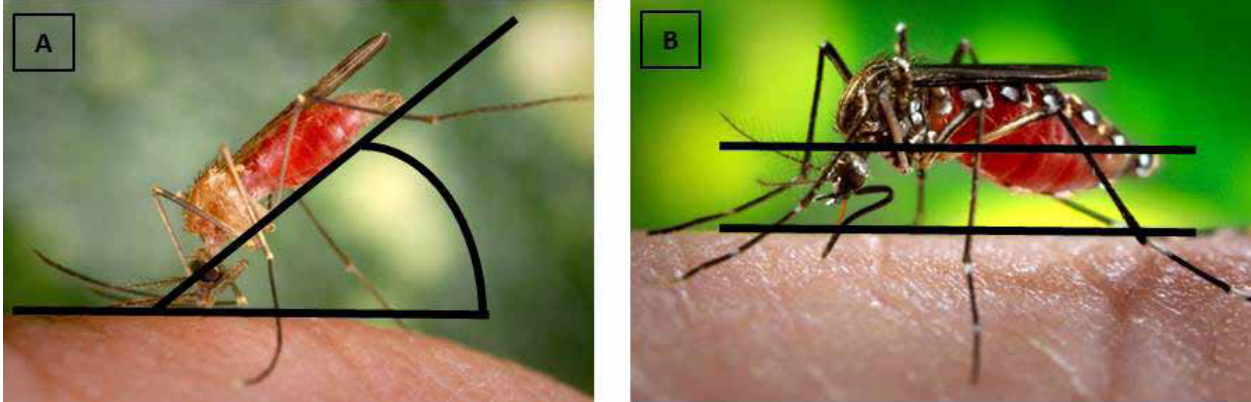
Figure 1: The resting/feeding stance of the female Anopheles species (A), which differentiates them from other non-malaria transmitting vectors, such as Aedes aegypti (B).